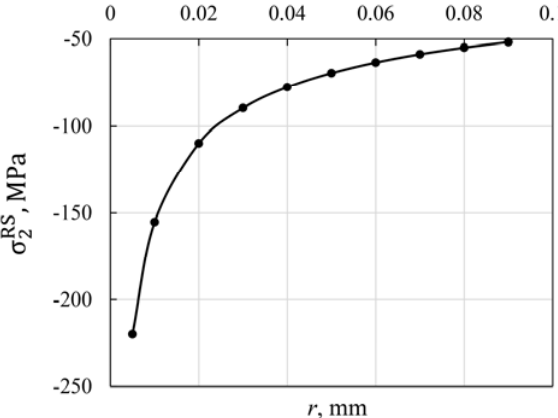
RS at different distances from the tip of notch of  2